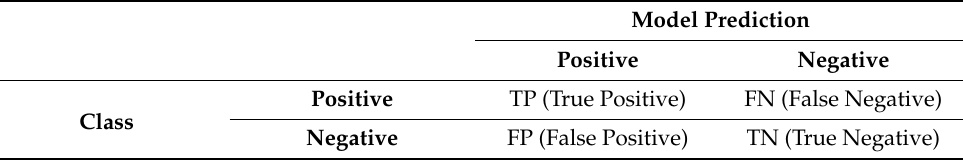
Table 1. Confusion